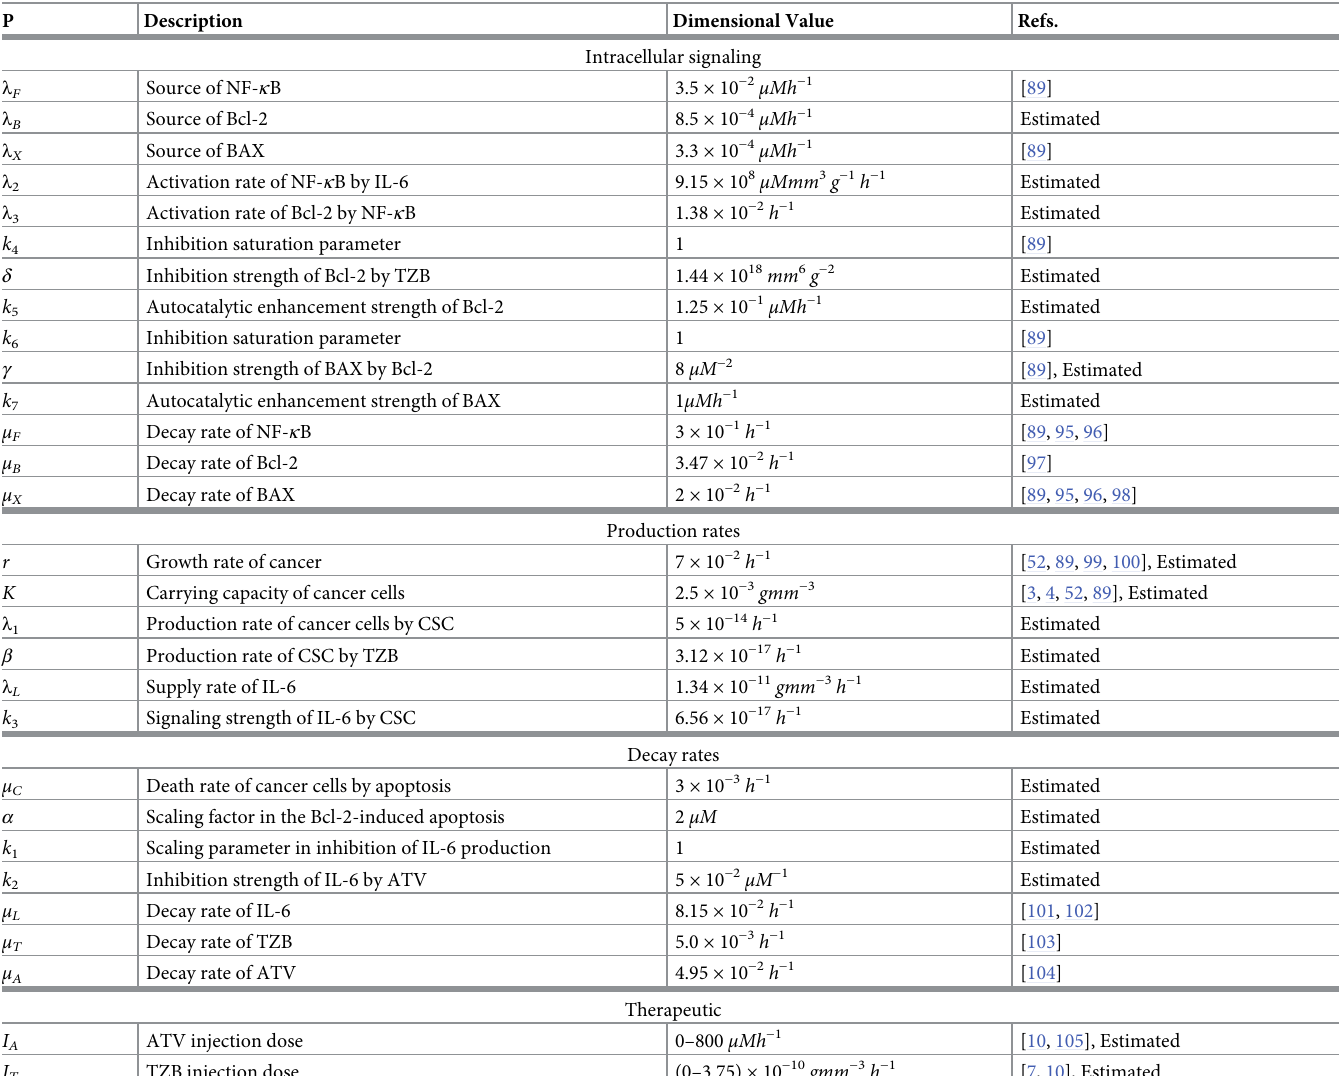
Table 1. Parameters in the model. P =